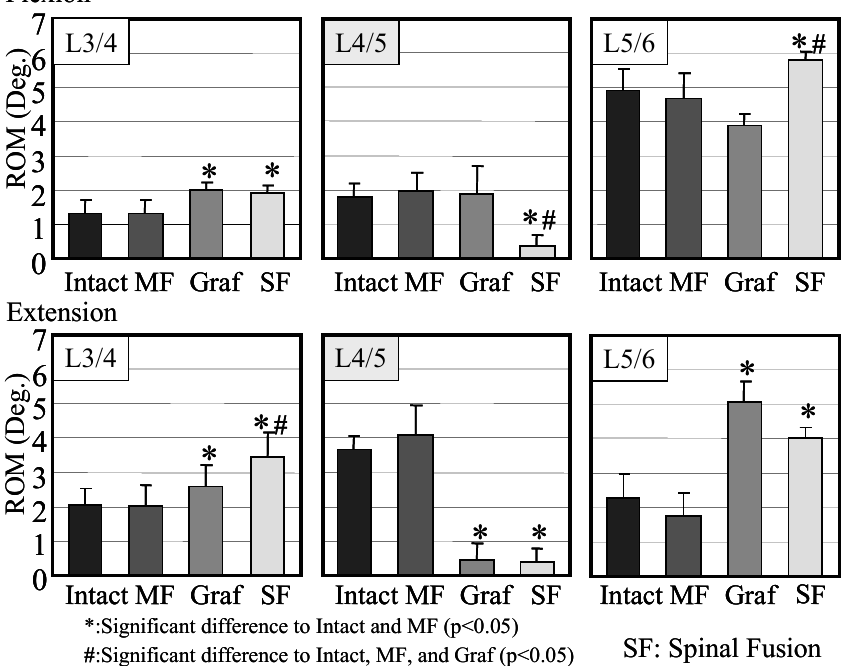
Fig. 4 Data on the range of motion for each instrumented model. For the superior adjacent segment, in both instrumentation groups, the ROM was significantly greater than in the intact or MF spine in both positions. For the inferior segment (L5/6), the ROM increased in flexion with spinal fusion, in extension with the Graf system and with spinal fusion. At L4/5, while in extension, the ROM decreased with the Graf system and with spinal fusion; both differences were significant compared to the intact or MF spines.